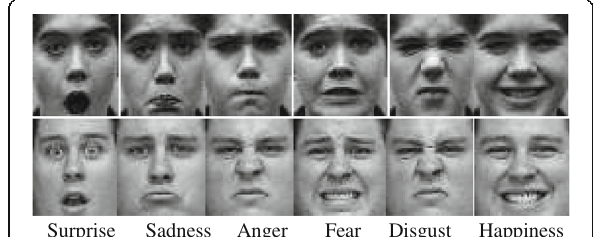
Fig. 1 Cropped face images of six facial expressions from